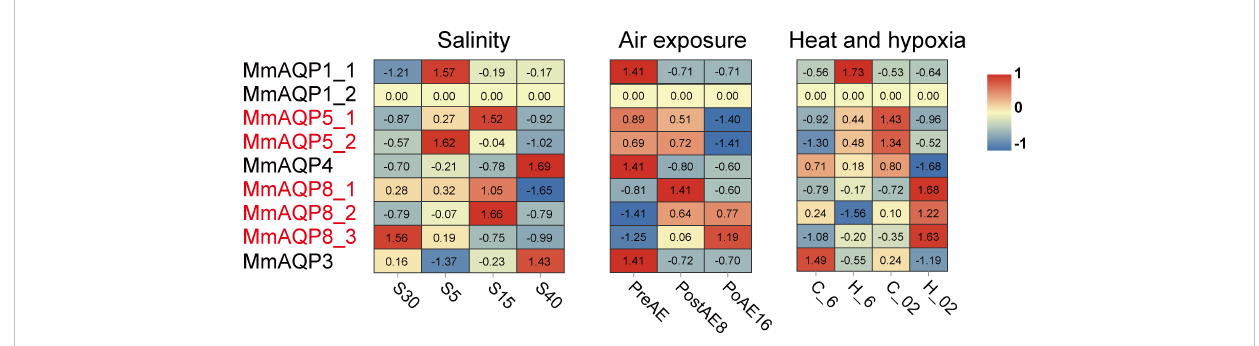
FIGURE 7 Heatmap analysis of MmAQP genes in response to salinity, air exposure, and heat and hypoxia stress. Red indicates a high level of gene expression, and blue indicates low expression. The tandemly-duplicated genes are marked in